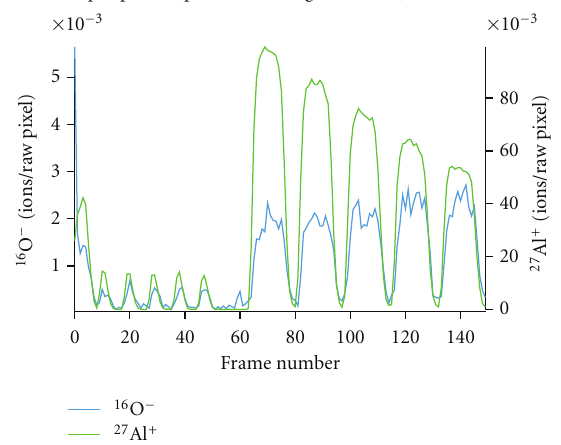
Figure 14: Overlay of depth profiles of aluminium and oxygen for VECSEL 3/1. Note the oxygen peak at frame 60, close to the interface between the two wafers. The smooth drop in the aluminium signals (not evident in Figure 12) was later discovered to be due to a temporary contamination of the ion